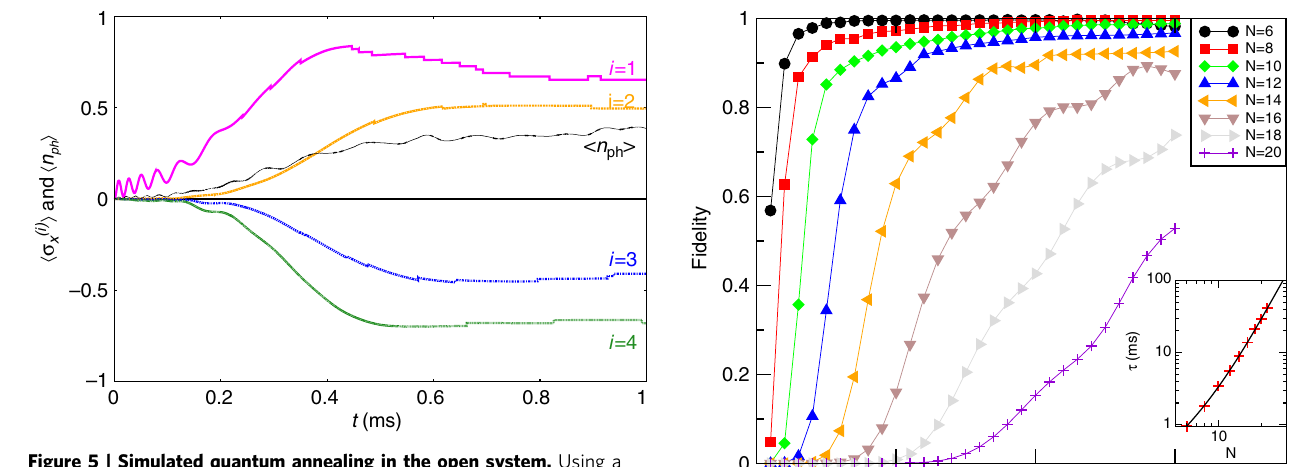
NATURE COMMUNICATIONS|7:11524|DOI: